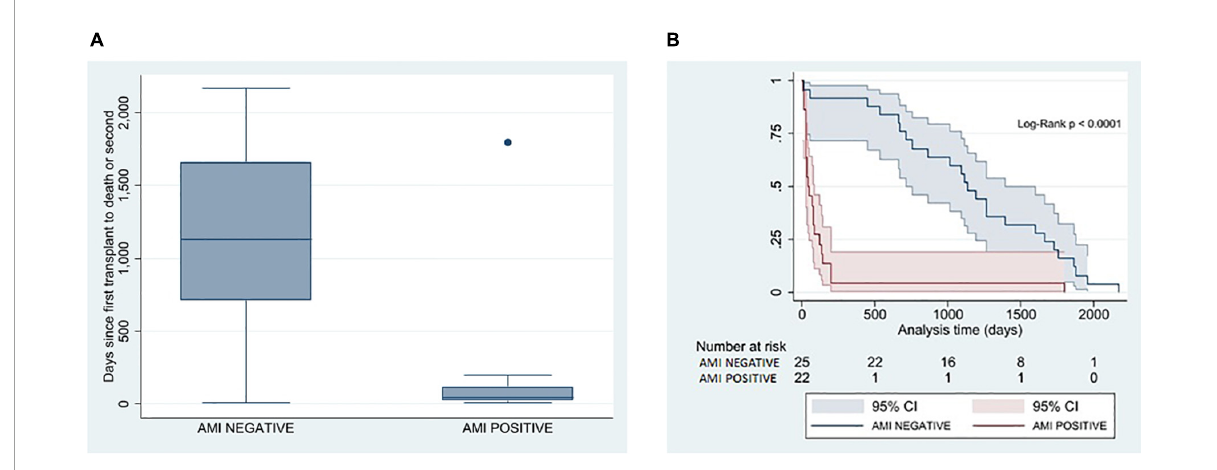
FIGURE2 Correlation between pathological presence of AMI in EMB and time from the first transplant to death or re-transplant. (A) Box plot analysis between AMI and non-AMI patients on time from the first transplant to death or re-transplant in days. (B) Kaplan–Meier estimator on freedom-from hard outcome death or re-transplantation between the AMI (red) and non-AMI patients (blue). AMI, acute myocardial injury; EMB, endomyocardial